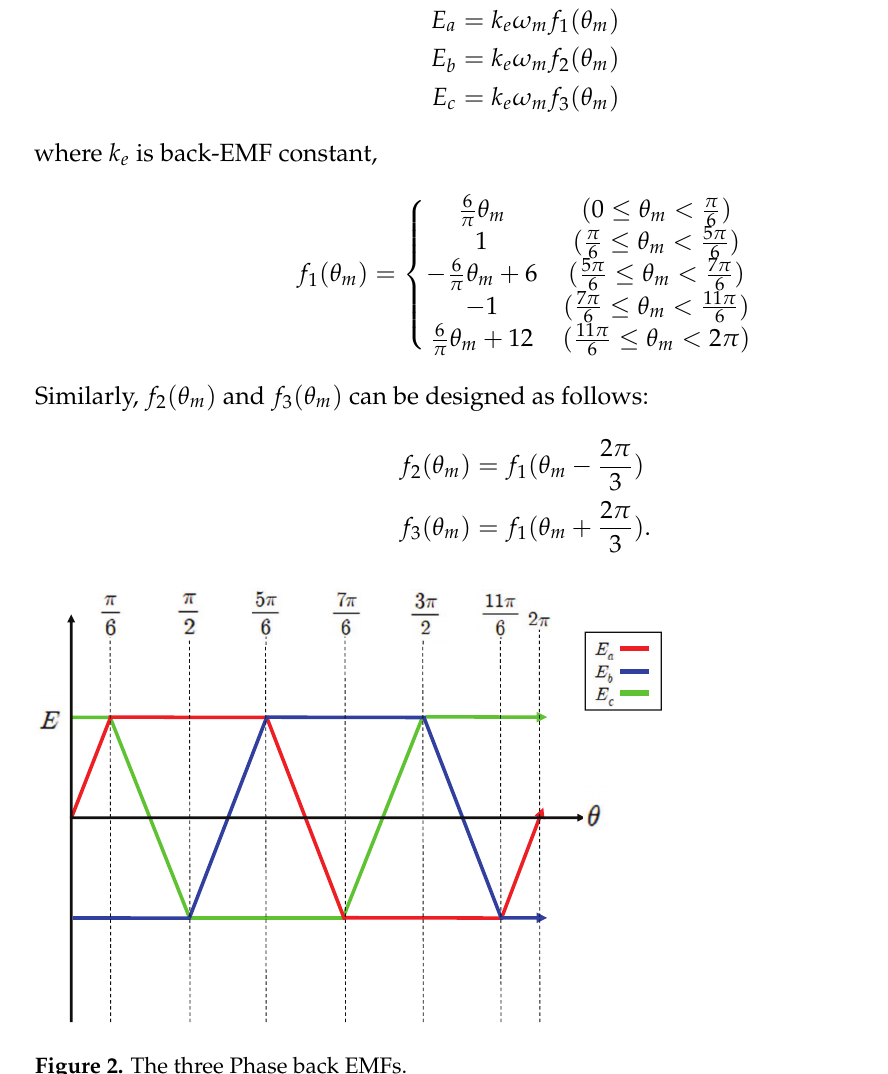
Figure 2. The three Phase back